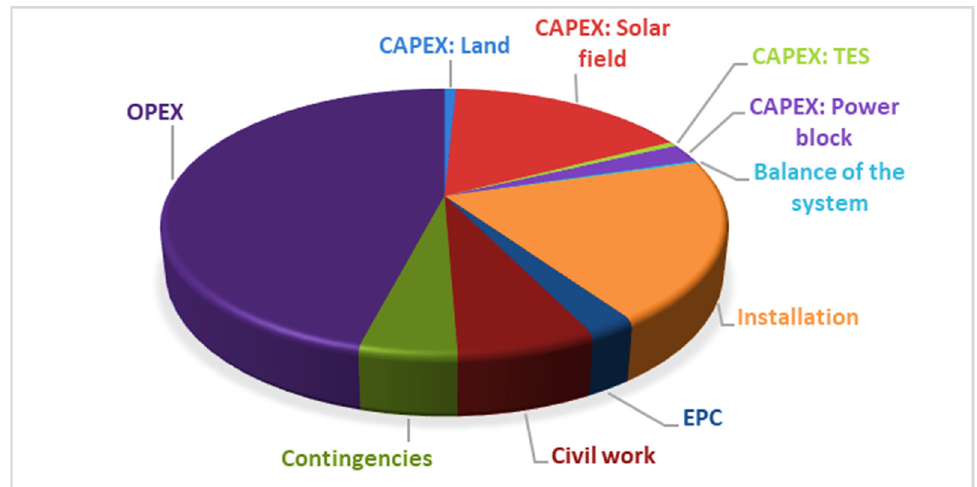
Figure 5. Share of expenses for base case parabolic trough plant over 25 years. Table 9. Details of the solar power tower plant under scenario 13—the base case for SPT plants. Table 8. Details of the parabolic trough plant under scenario 1—the base case for PT